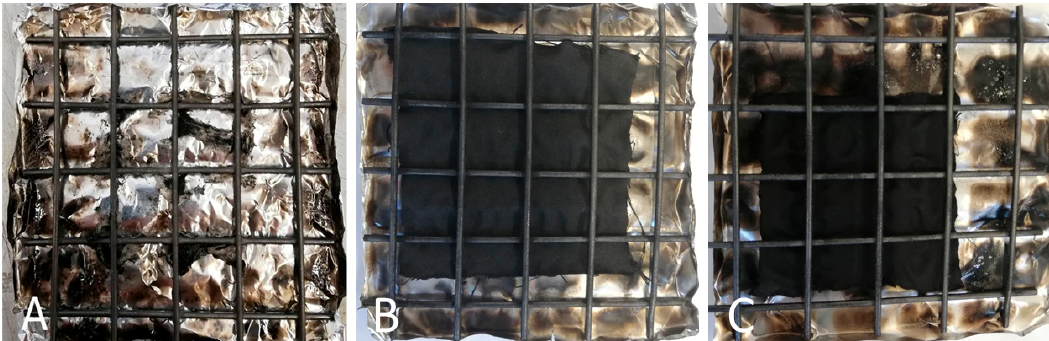
Figure 12. EDX mapping of the residue of COT+PA+BC(8) W after horizontal flame spread tests.